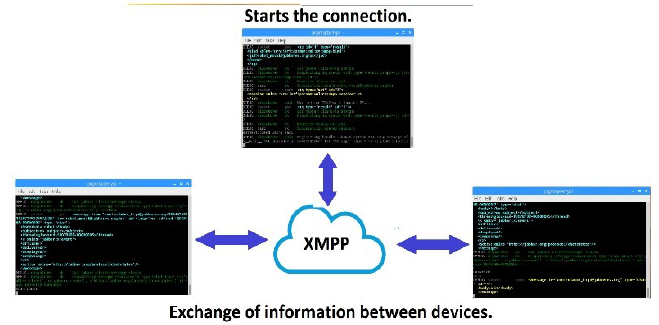
Figure 23. The connection via the Internet. First, it is necessary to establish the connection between the devices. After that, the devices will communicate with each